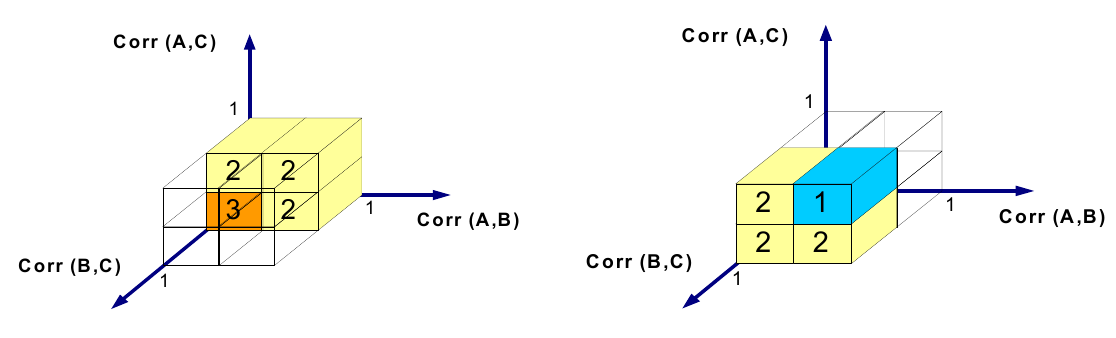
Figure 15. Classification